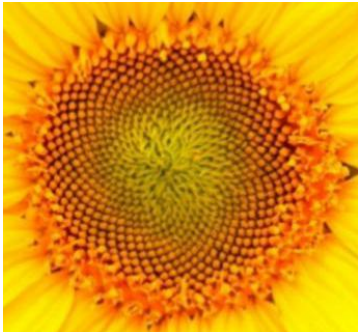
Figure 3. A magnified sunflower.